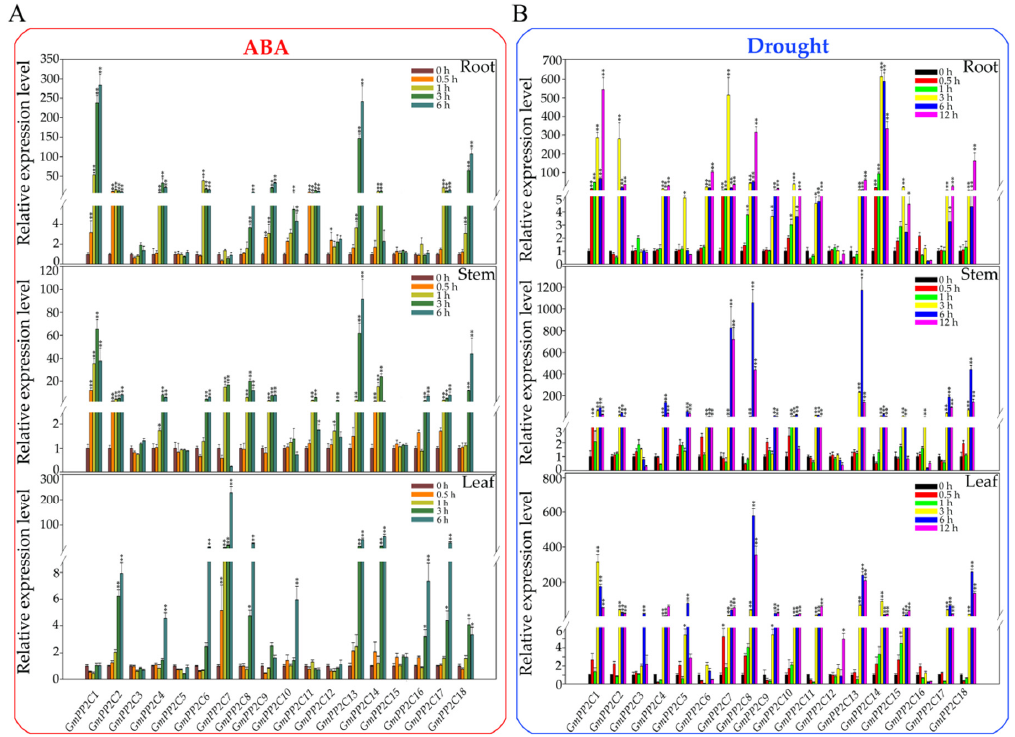
Figure 8. Expression analysis of GmPP2C-As under ABA and drought treatments. ( A ) Expression analysis of GmPP2C-As in the roots, stems and leaves of soybean under ABA treatment. ( B ) Expression analysis of GmPP2C-As in the roots, stems and leaves of soybean under drought treatment. The expression levels in the roots, stems and leaves before treatment (0 h) were used as controls and were assigned a value of 1. GmSKIP was used as an internal reference. Each point represents the mean value ± SE of three independent experiments performed in triplicate. The differences were statistically assessed using Student’s t test (**, p < 0.01; *, p < 0.05). The error bars in A and B represent the SEs of three replicates.